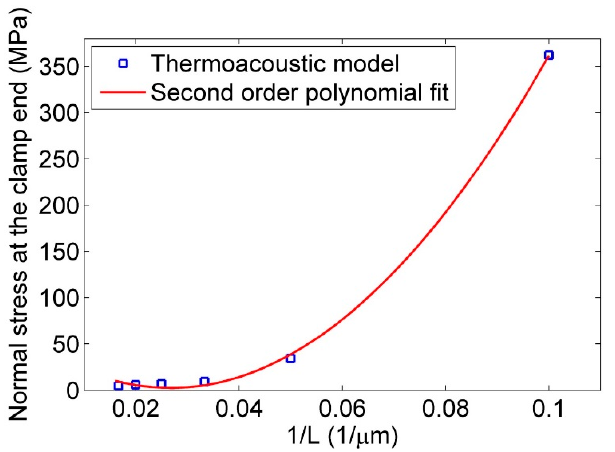
Figure 11. Effect of length on the normal stress at the clamp end of nanowire. The analytical model’s findings match the results of the thermoacoustic model ( σ xx ∝ 1